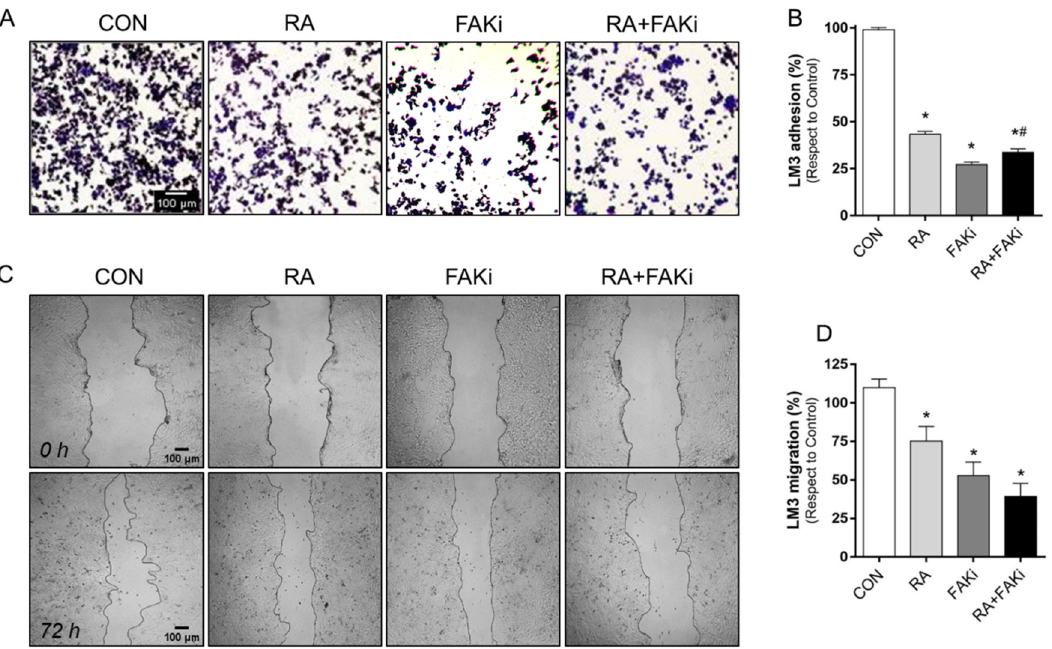
Figure 4. RA plus FAKi controls LM3 cell adhesion and migration. LM3 cells were treated with 1 µ M RA, 1 µ M FAKi or their combinations 1 µ M RA + 1 µ M FAKi for 72 h and cell adhesion and migration assay was performed. ( A , B ) Representative images and percentages of LM3 cells adhered to gelatin and ( C , D ) LM3 cell migration are shown. The gap closure was quantified by the use of ImageJ software. Adhesion/migration results were expressed as a percentage of attached/migrated cells vs. control cells, CON. * = p < 0.05 vs. control, CON. # = p < 0.05 vs. RA. Measures are from three independent experiments.